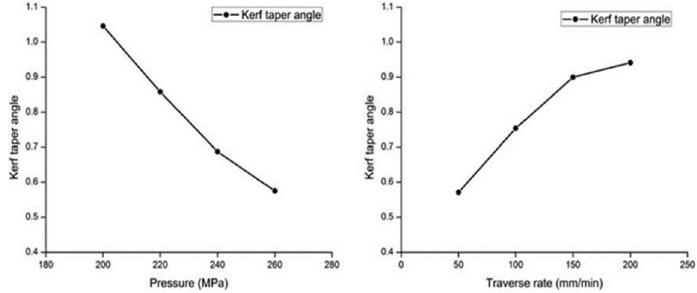
Figure 8. The effects of pressure and traverse rate on Kerf Taper [49]. Figure 8. The e ff ects of pressure and traverse rate on Kerf Taper [49].